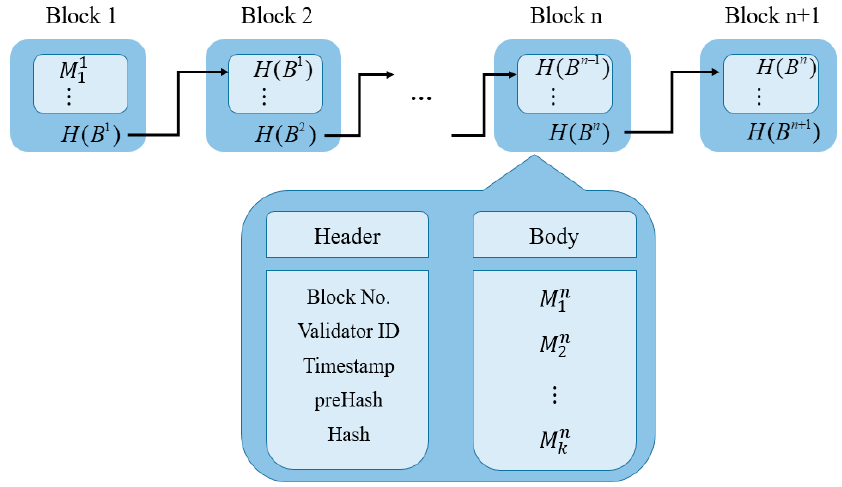
Figure 1. The general data structure of blockchains.